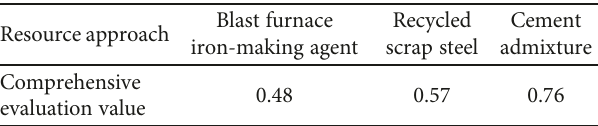
Table 6: Resource utilization recommendations. Resource